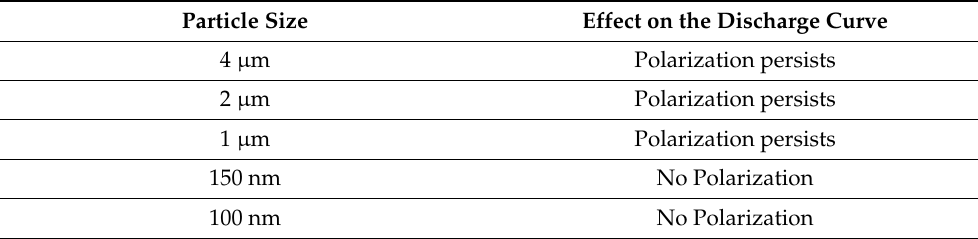
Table 4. Summary of the effect of particle sizes of the Si electrode (with NCA cathode) on the shape of the discharge curve after 2000 cycles.